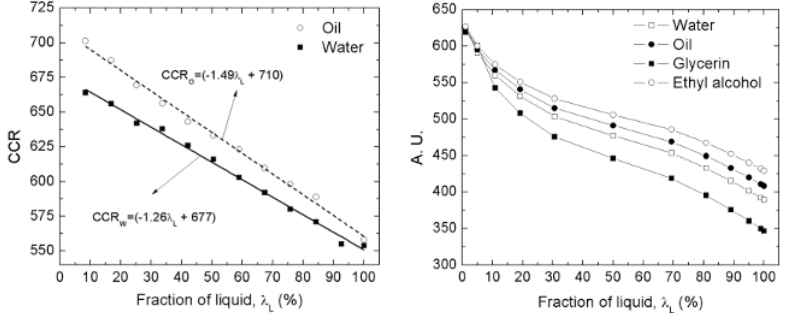
Figure 4. (Left) Comparison of the coincidence count rate between air-water and air-oil two-phase fluids in different percentages. (Right) Monte Carlo simulations of several two-phase